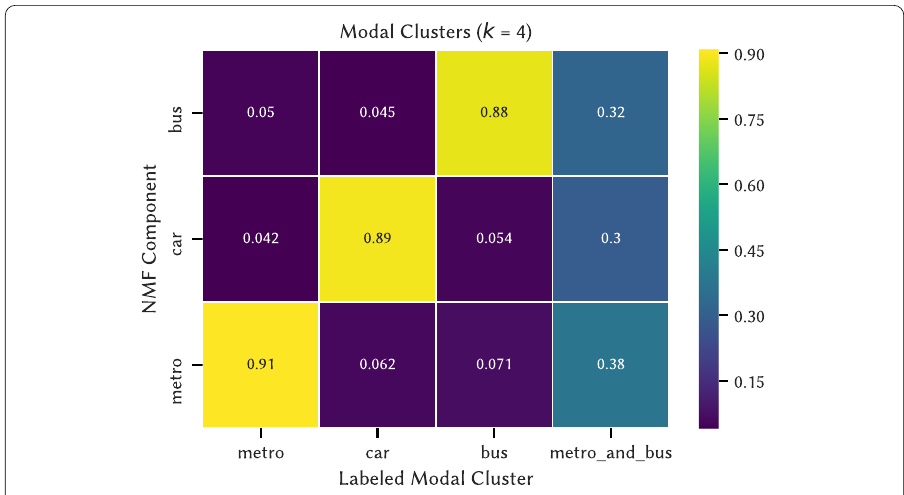
Figure 10 Depiction of the modalclusters obtained after applying k-means to the user-component matrix. In this visualization, each column contains the centroid coordinates of its corresponding modal cluster